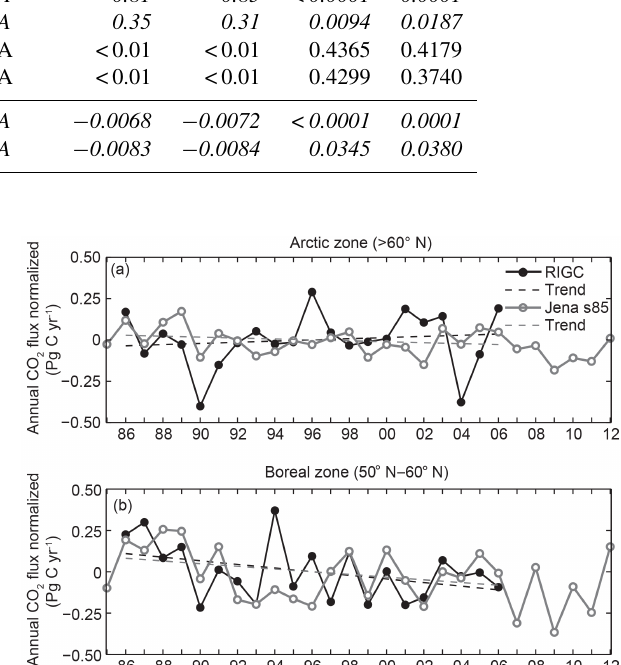
Figure 2. Annual CO 2 fluxes normalized by subtracting the 1986– 2006 mean value for (a) arctic zone (>60 ◦ N) and (b) boreal zone (50–60 ◦ N). Black shows the RIGC inversion results. Grey shows the Jena s85 inversion results. Dashed lines are linear trends from 1986 to 2006 (value in Table 2). Negative values represent uptake of CO 2 by the land biosphere, i.e., out of the